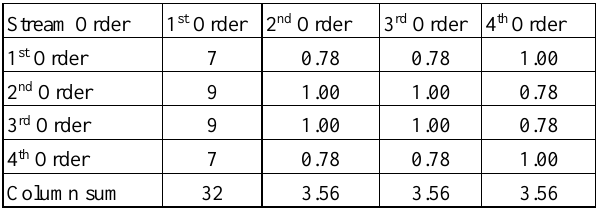
Table 7. Deriving the relative weights of the runoff factor